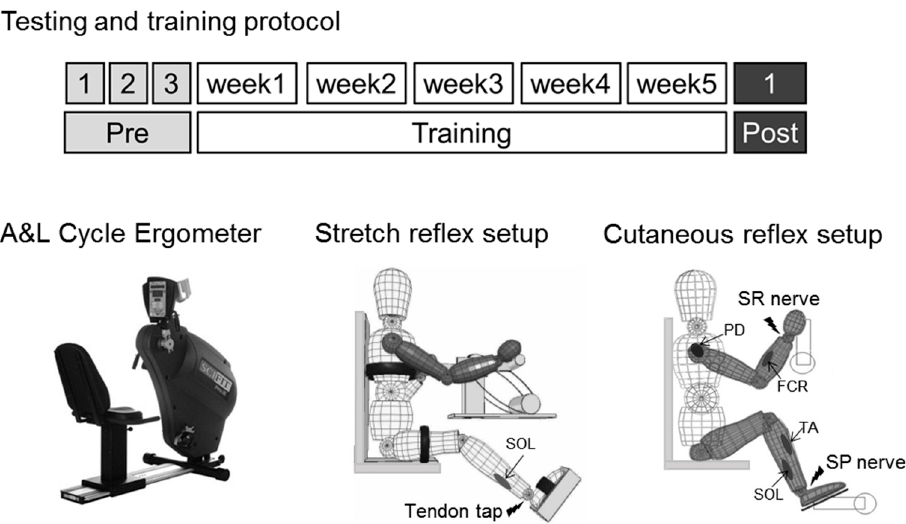
Figure 1. Illustration of the testing and training protocols. A multiple baseline within-subject control design was used for this study. An A & L cycle ergometer (Sci-Fit Pro 2) was used for training. The setups for stretch reflex and cutaneous reflex testing are shown. Muscles of interest are shown with a gray oval, and electrical stimulation is shown with a black lightning bolt. For the stretch reflex setup, a brief vibration was delivered to the triceps surae tendon and the reflex was recorded from the soleus (SOL) muscle, separately for each side. For the cutaneous reflex setup, simultaneous electrical stimulation was applied to the superficial radial (SR) and the superficial peroneal (SP) nerves, and reflexes were recorded bilaterally from the soleus (SOL), tibialis anterior (TA), flexor carpi radialis (FCR), and the posterior deltoid (PD) muscles.